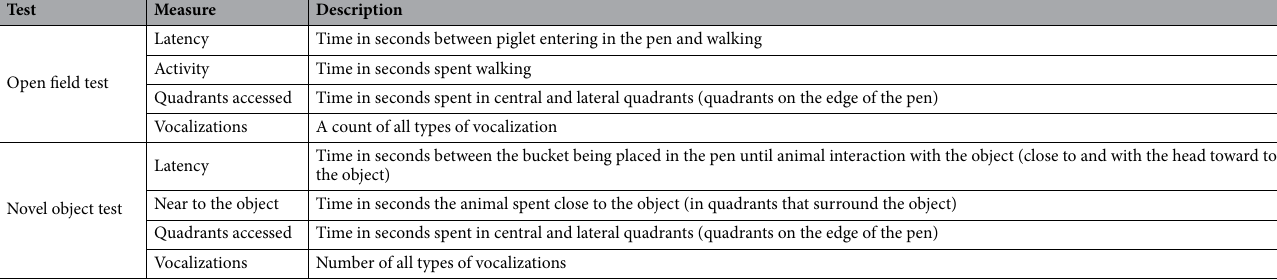
Table 4. Description of data collected during open field and novel object test.